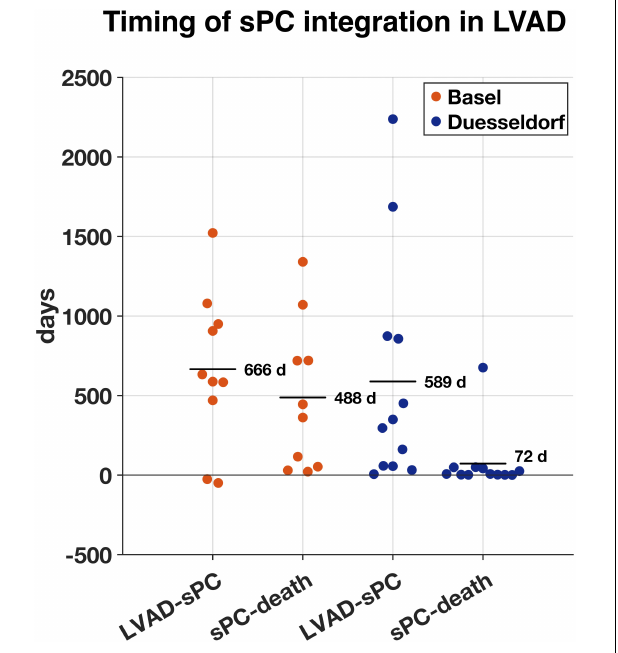
TABLE 1 | Patient characteristics ( n = 22).